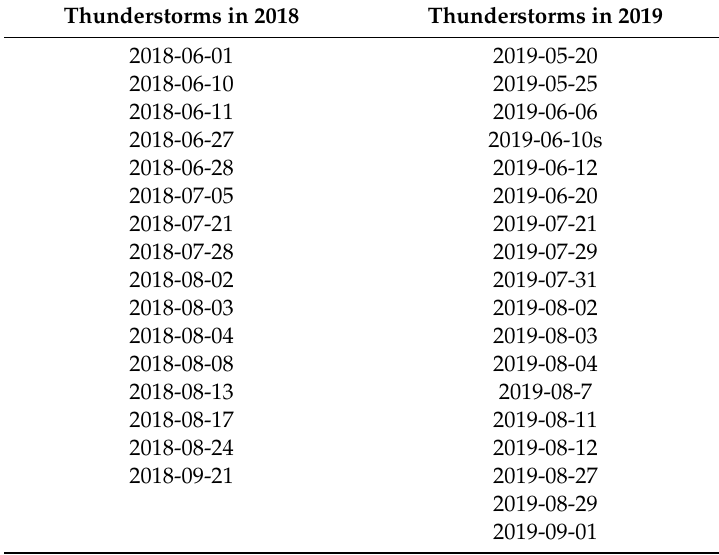
Table 3. Date of 38 days of thunderstorms with lightning discharges recorded up to 20 km from the Milešovka observatory in 2018 (left panel) and 2019 (right